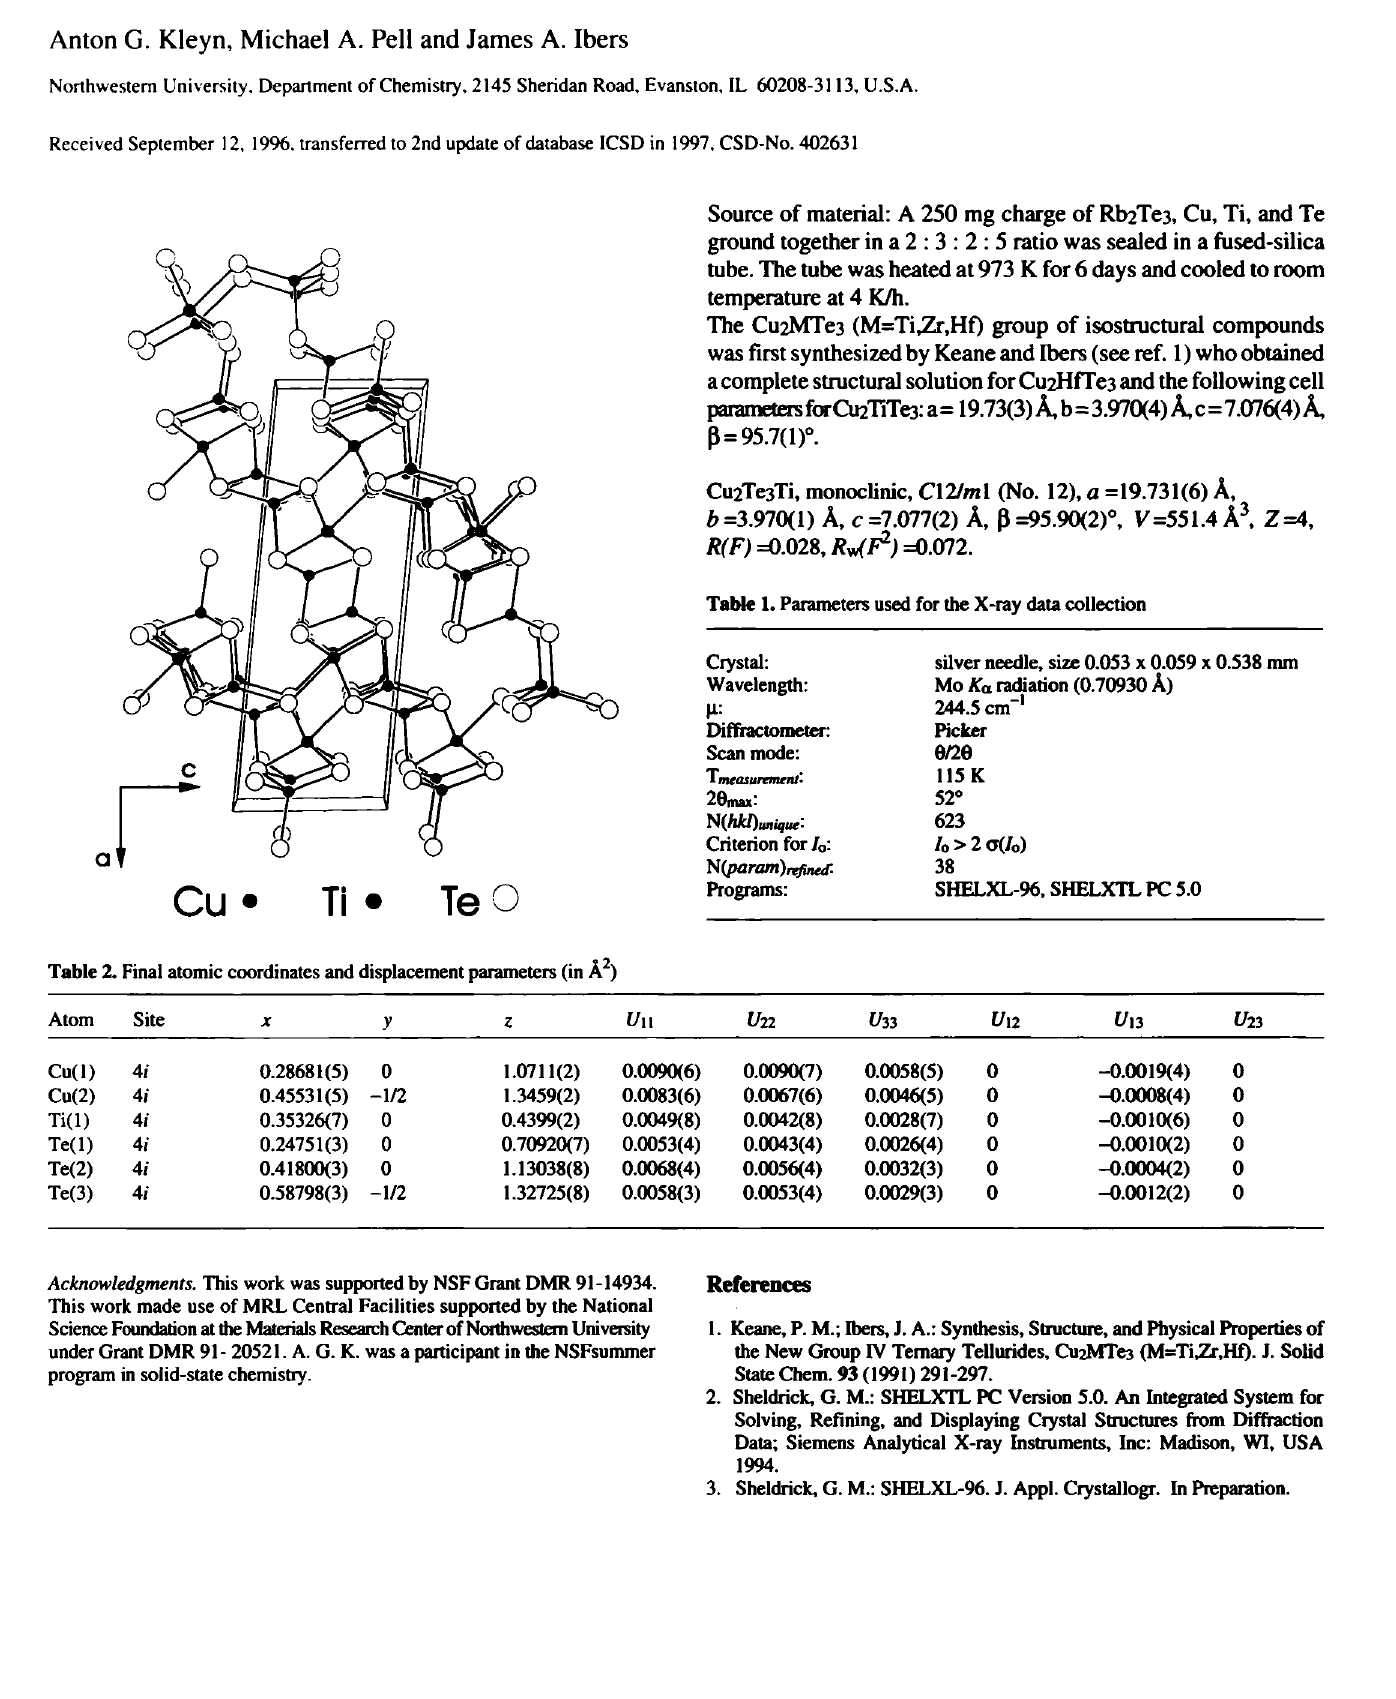
Table 1. Parameters used for the X-ray data collection